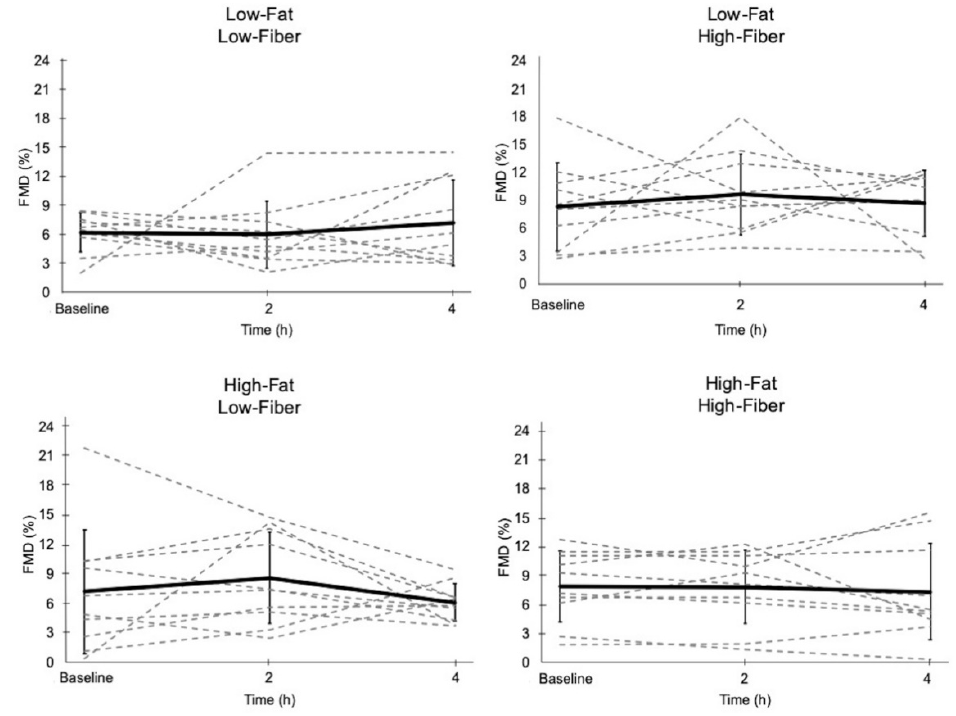
Figure 7. Endothelial function, as measured by flow-mediated dilation (FMD), following the four meals. Dashed lines represent responses for each individual. Solid line represents the mean response (± SD). FMD was not different across time points for all meals. Table 9. Regression between changes in 4 h plasma triglycerides and 4 h FMD for the four meals.